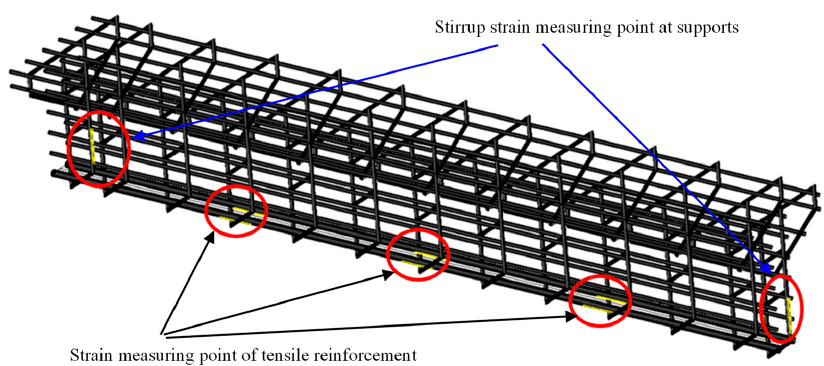
Figure 2. Arrangement of measuring points (unit: mm).